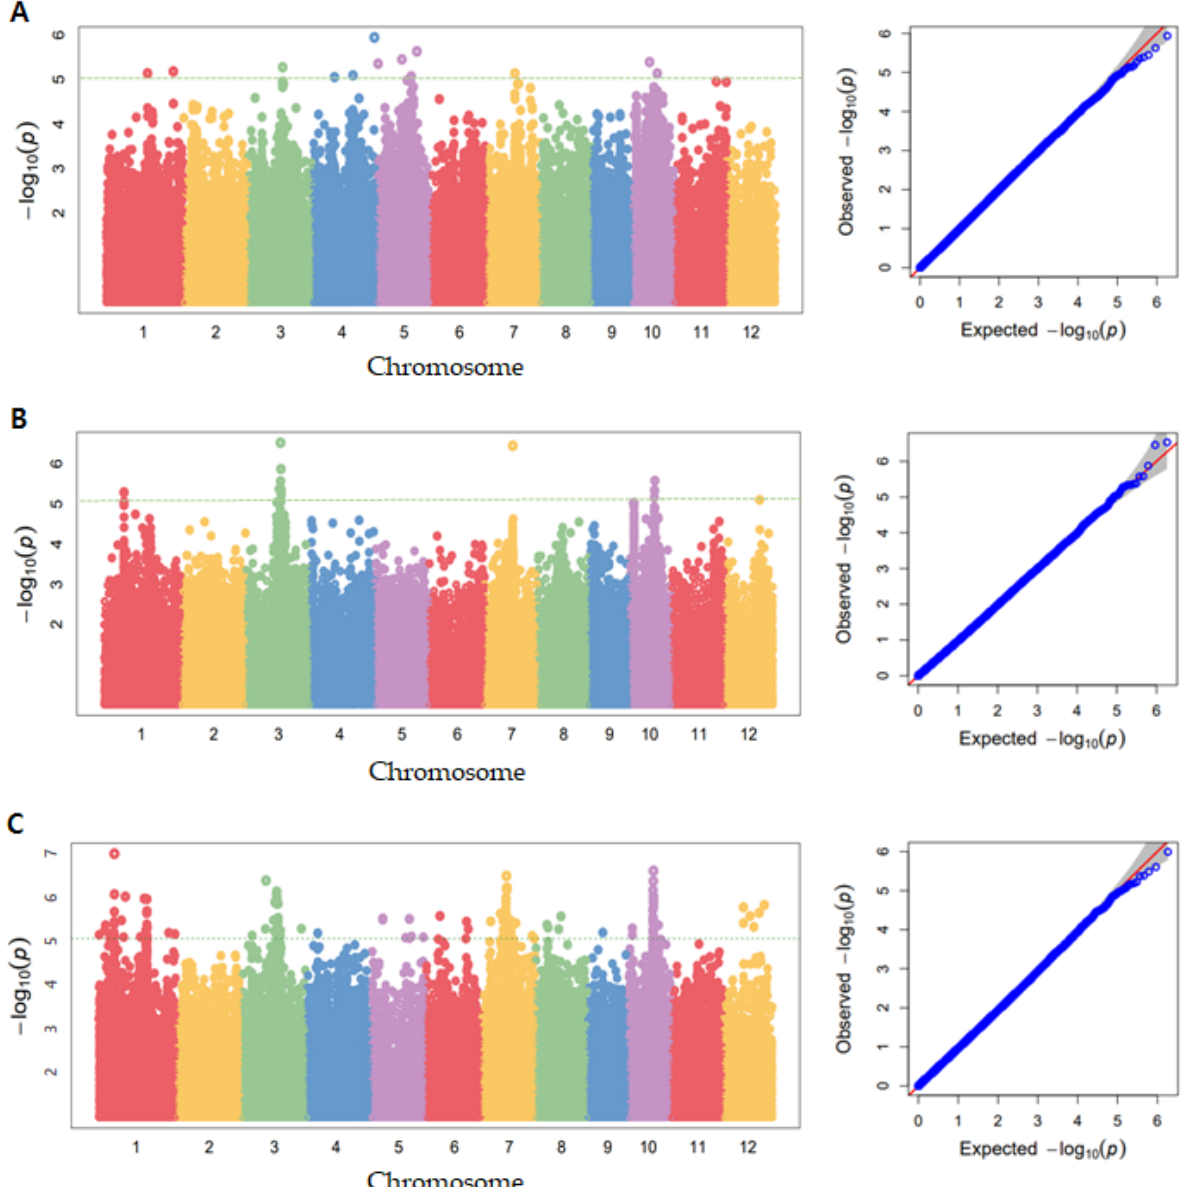
Figure 4. Genome-wide association study of seed coat and aleurone layers by region in the 294 rice core collection. The − log 10 ( p ) values from a genome-wide scan are plotted against the position on each of the 12 chromosomes. ( A ) The thickest part, ( B ) middle part, and ( C ) thinnest part.